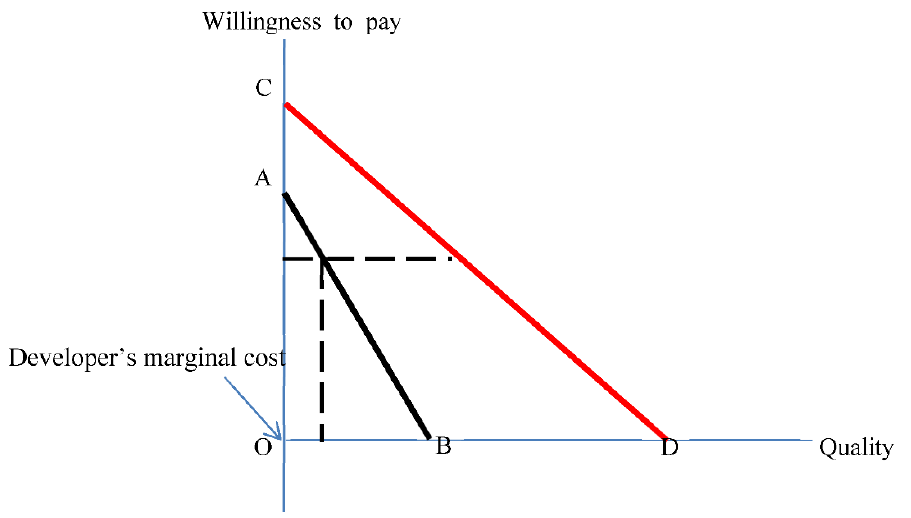
Figure 5. Dwelling demand (AB) and speculative demand (CD).